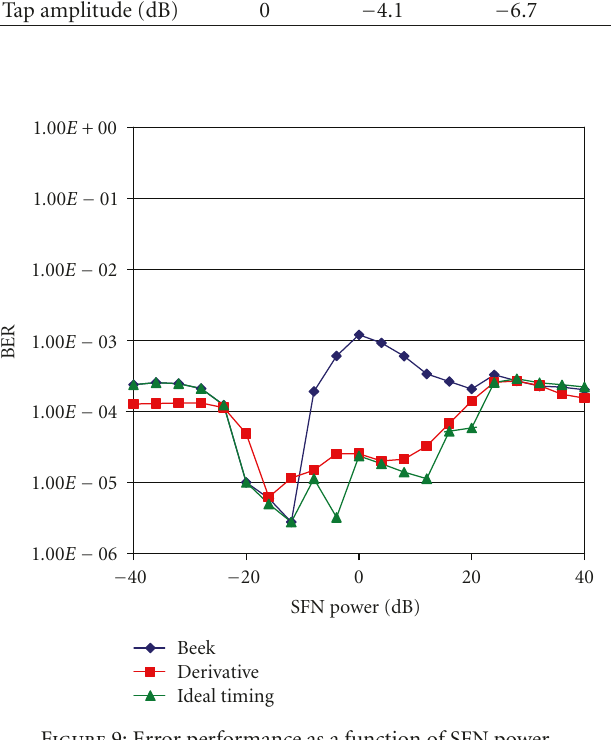
Figure 9: Error performance as a function of SFN